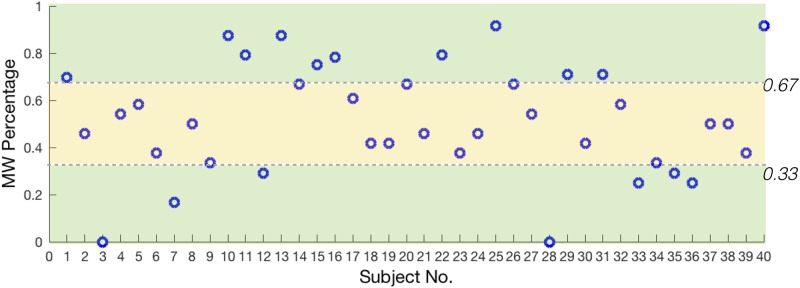
The MW proportion of each participant.